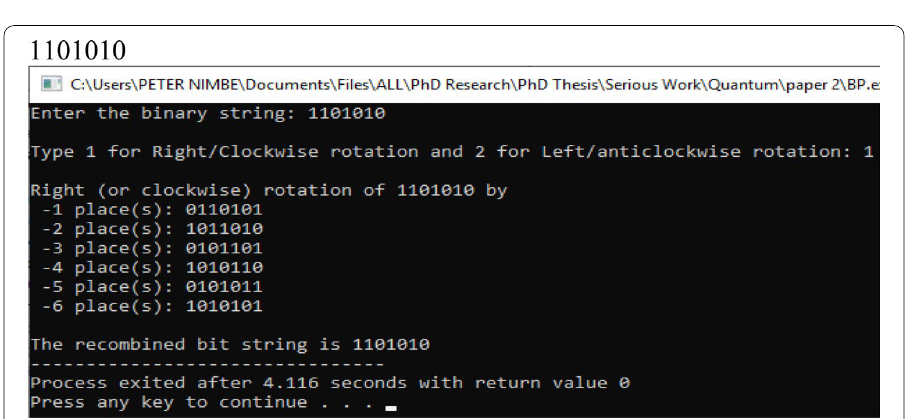
Fig. 20 Right or clockwise rotation of 1101010